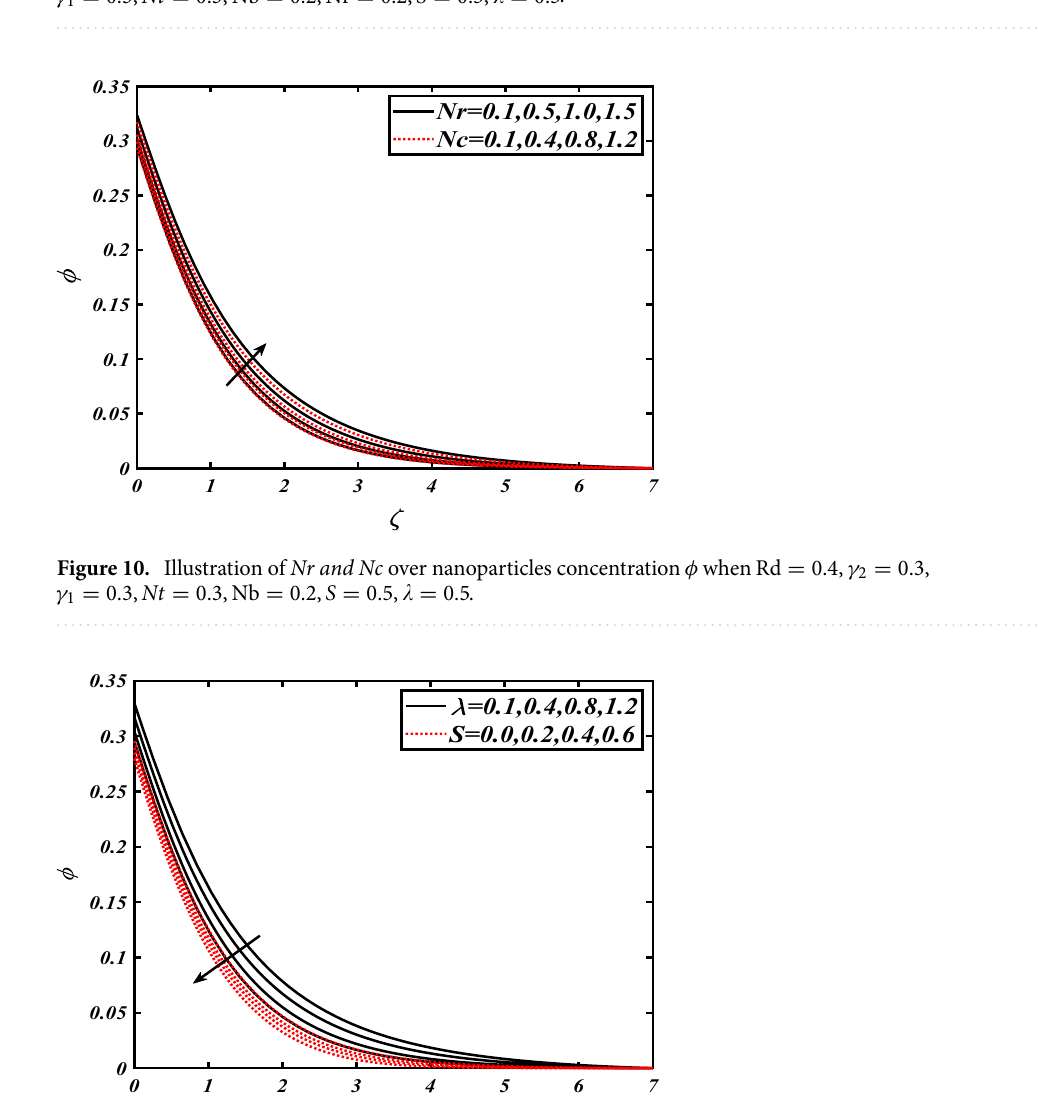
Figure 9. Illustration of Pr and β over nanoparticles concentration φ when Rd = 0.4, γ 2 = 0.3, γ 1 = 0.3, Nt = 0.3, Nb = 0.2, Nr = 0.2, S = 0.5, (cid:31) = 0.5 .